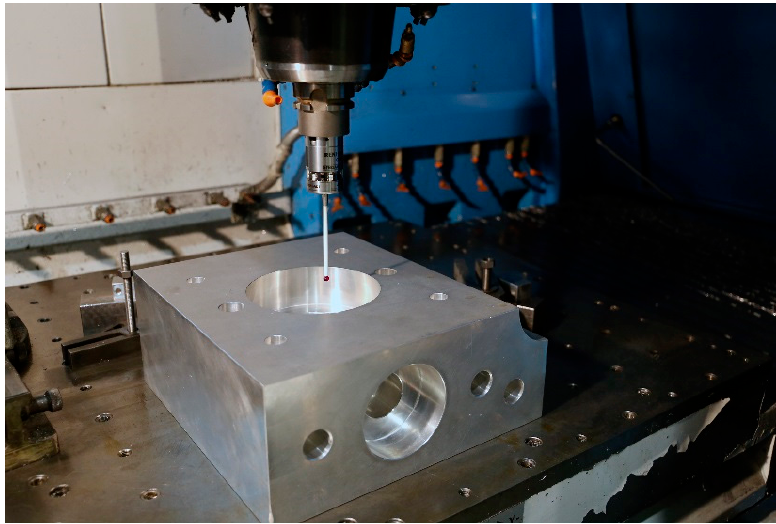
Figure 3. Tactile machine tool probing.